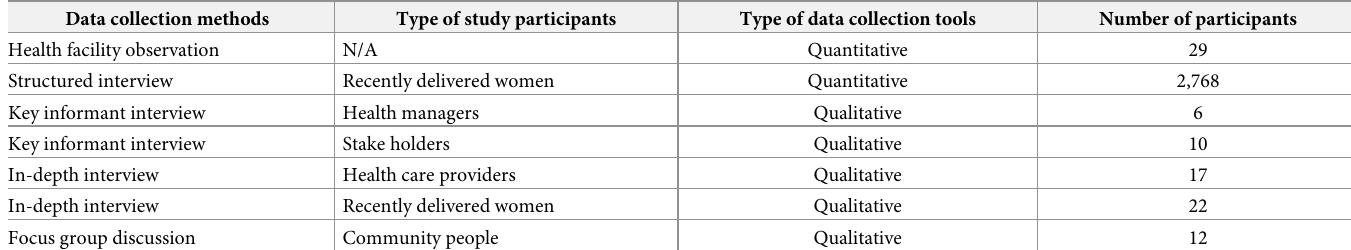
Table 1. Data collection methods and sample size of the study